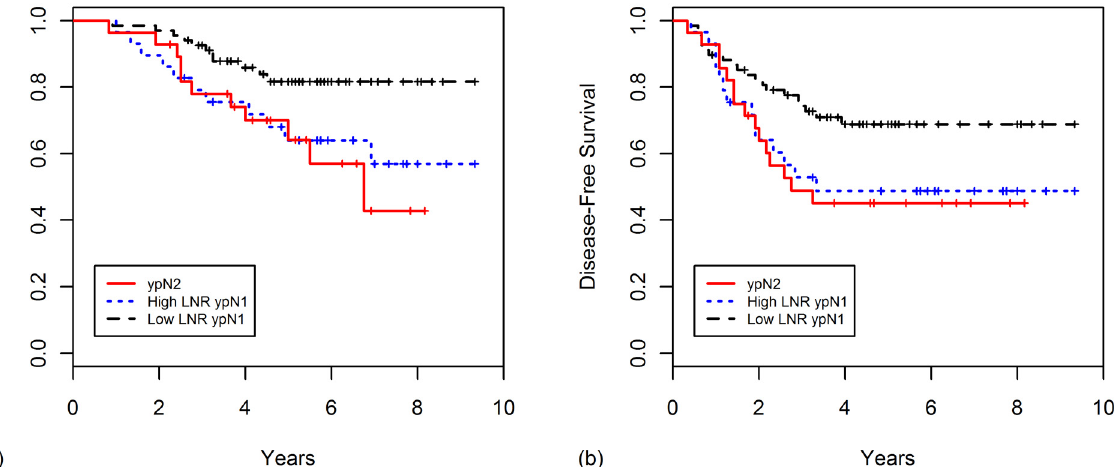
Fig 2. Kaplan-Meier curves for (A) overall survival and (B) disease-free survival according to ypN stage and lymph node ratio (low LNR ypN1, high LNR ypN1, and ypN2